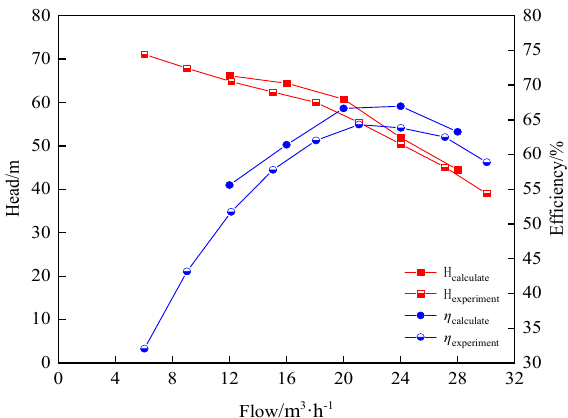
Figure 7. Comparison of pump performance between numerical and experimental results.